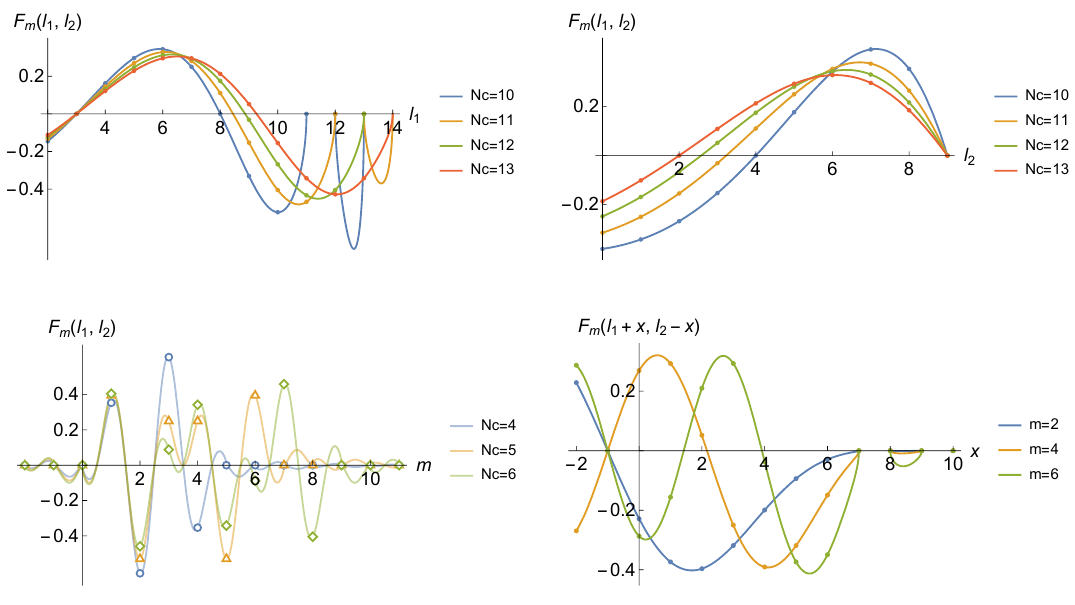
Figure 4 . Plotting the function F m ( l 1 , l 2 ) against l 1 , l 2 (above) and m, x